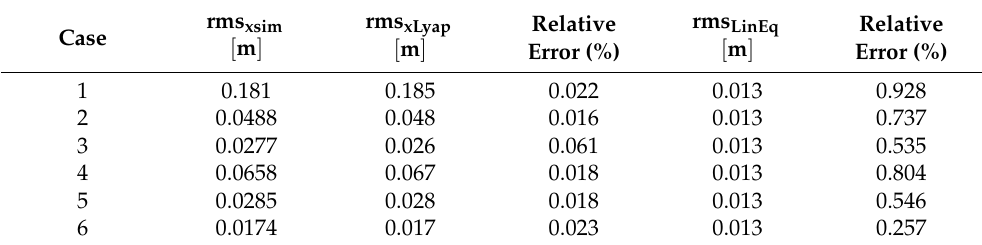
Table 5. The rms values and relative errors for relative displacements.